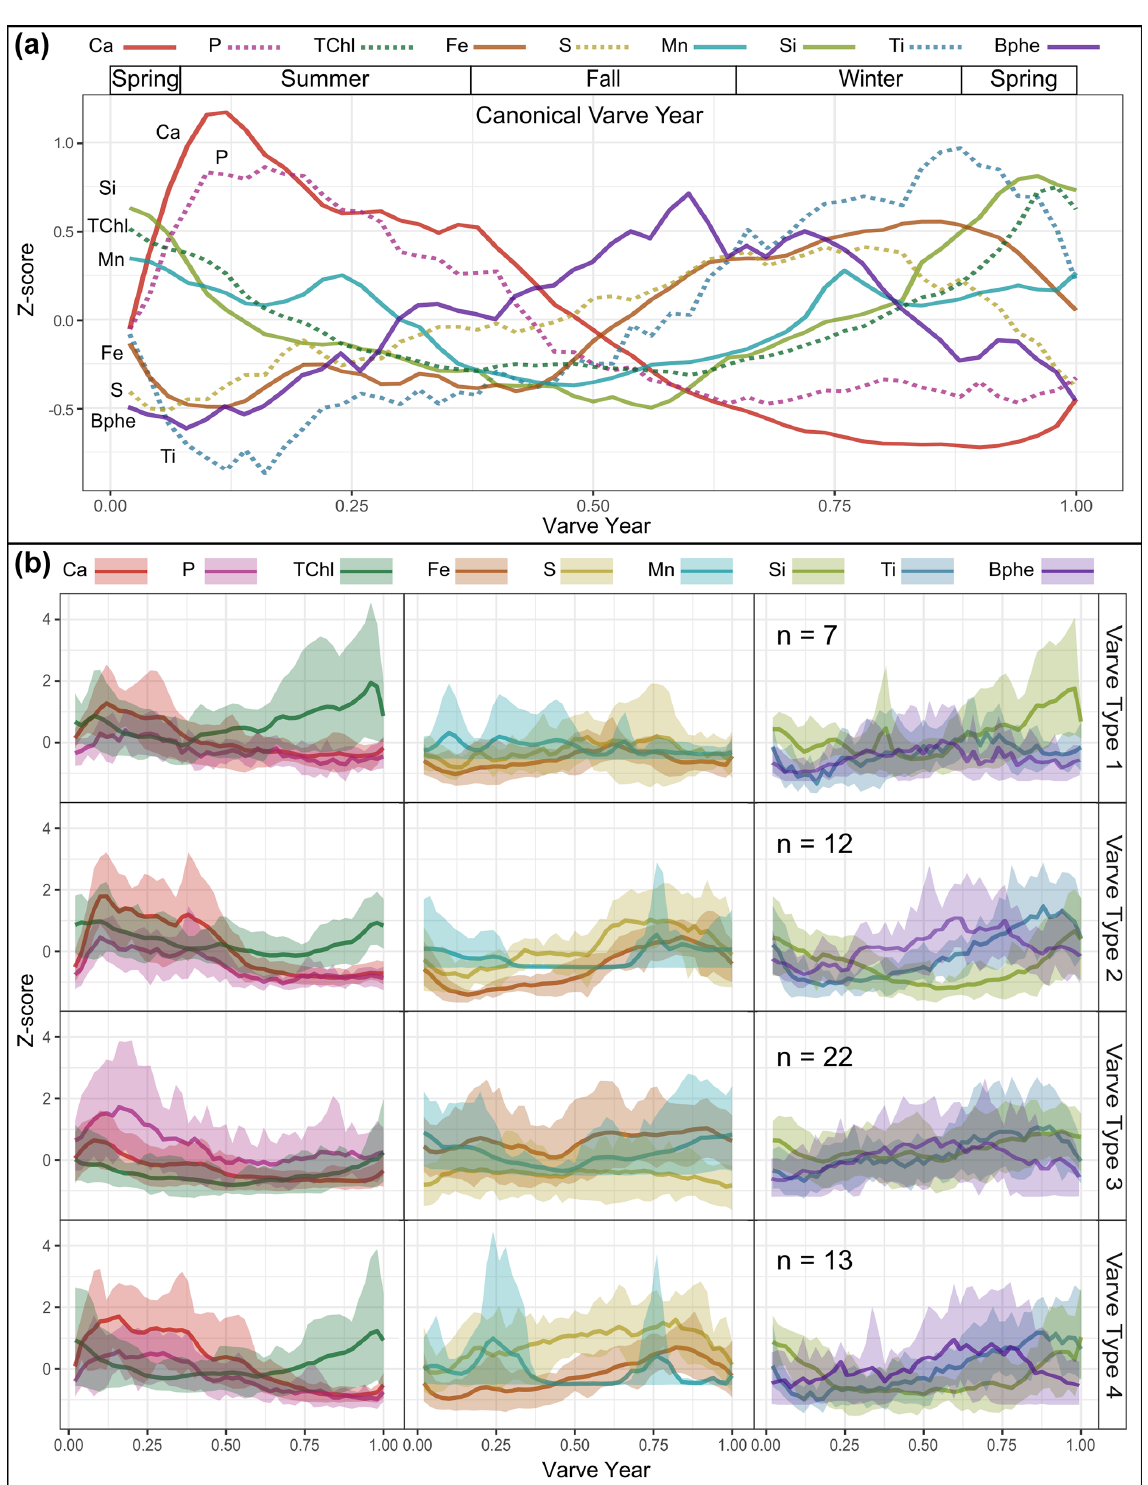
Figure 4. (a) Average annual sequence of key geochemical variables across a varve year. Varve year begins in spring with calcite precipi- tation. (b) Groups of annual time series determined from hierarchical clustering based on the dissimilarity measure ψ applied to the annual time series. Data plotted are means of varve types, with shaded regions representing 80% of the data for each group.